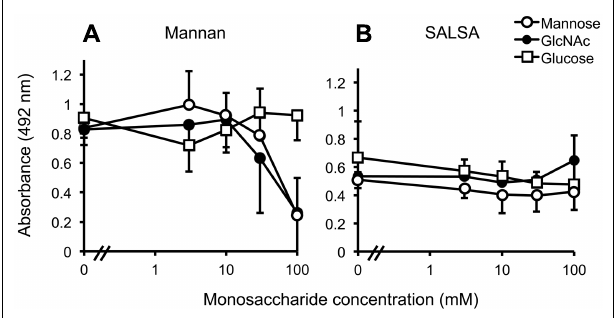
FIGURE 3 |The effect of monosaccharides on MBL binding to mannan and SALSA. In an ELISA assay mannan (A) or rSALSA (B) were coated on a microtiter plate. rMBL (1 μ g/ml) was mixed with mannose, GlcNAc, or glucose (all 0–100 mM). Binding was detected with anti-MBL antibody.The presence of mannose and GlcNAc inhibited dose-dependently the binding of MBL to mannan while glucose had no effect (A) . In contrast, the binding of MBL to SALSA was not inhibited even by high concentrations of the saccharides (B) . Averages and SDs of three experiments performed in duplicate are